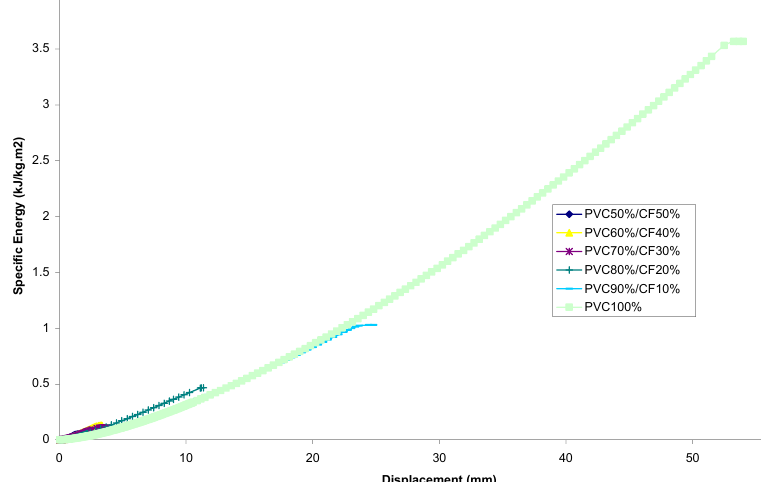
Figure 9. Energy versus displacement for averaged curve of cotton fiber reinforced PVC